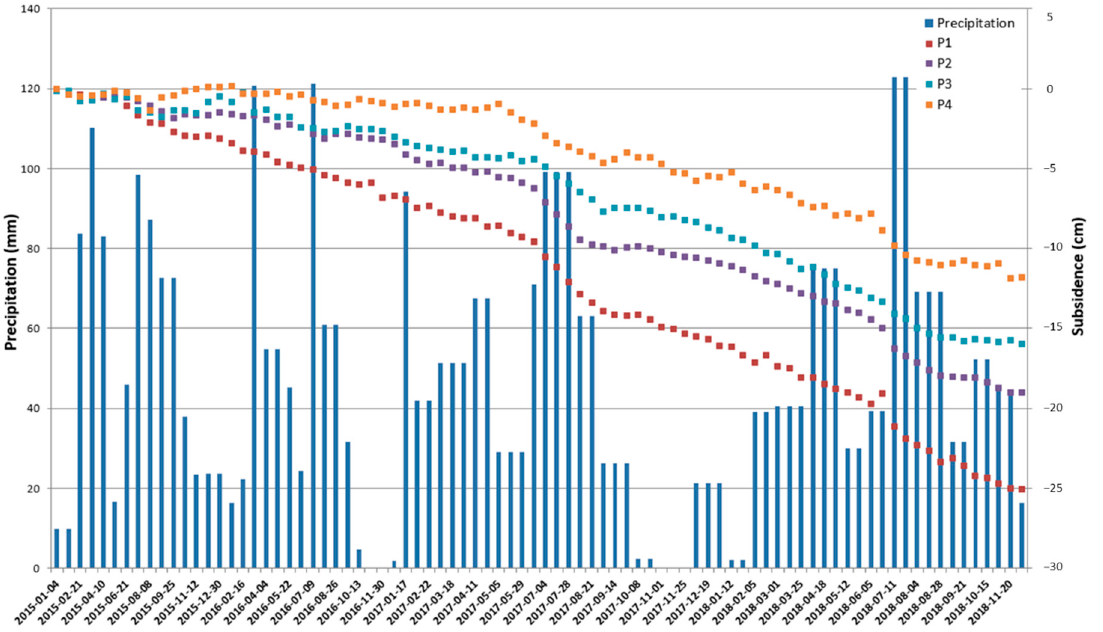
Figure 12. Time series LOS subsidence of PS points P1, P2, P3, and P4 versus daily precipitation at Kakul Station.